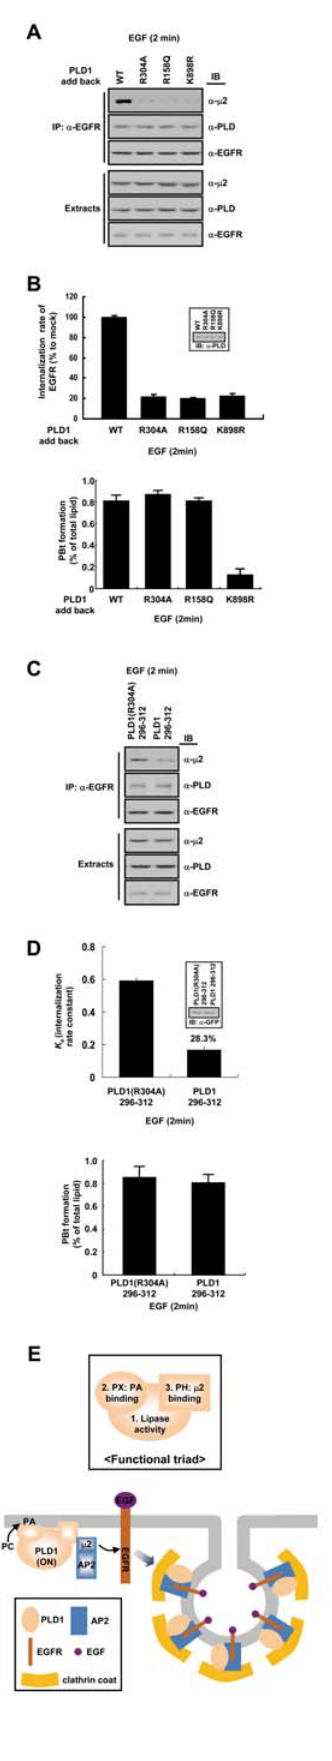
Figure 5. PLD1- m 2 interaction is important for PLD1-mediated EGFR endocytosis. (A) The recognition of EGFR by m 2 was analyzed by western blotting. Cell extracts were immunoprecipitated with anti- EGFR antibody and then immunoblotted using the indicated antibod- ies. (B) HeLa cells were transfected with wild type, R304A, R158Q, or K898R PLD1 after being depleted of endogenous PLD1. After 2 min of EGF (20 nM) treatment, the internalization rate of EGFR was measured as in Figure 1 (D). The PLD1 lipase activity was measured in a parallel experiment. Immunoblot in the insets indicates the expression levels of the constructs used. (C) and (D) The effect of PLD1- m 2 interaction on EGFR- m 2 association (C) and EGFR internalization rate (D) was checked. (E) Schematic representation of the proposed mechanism whereby PLD1 facilitates EGFR endocytosis in an auto-regulatory manner. Upon EGF stimulation, PLD1 is activated and generates PA. Association between PLD1 and PA through the PX domain of PLD1 increases the affinity of the interaction between the PH domain of PLD1 and m 2. This interaction enhances the translocation of AP2 onto the plasma membrane and the recognition of EGFR by m 2 facilitating EGFR endocytosis.